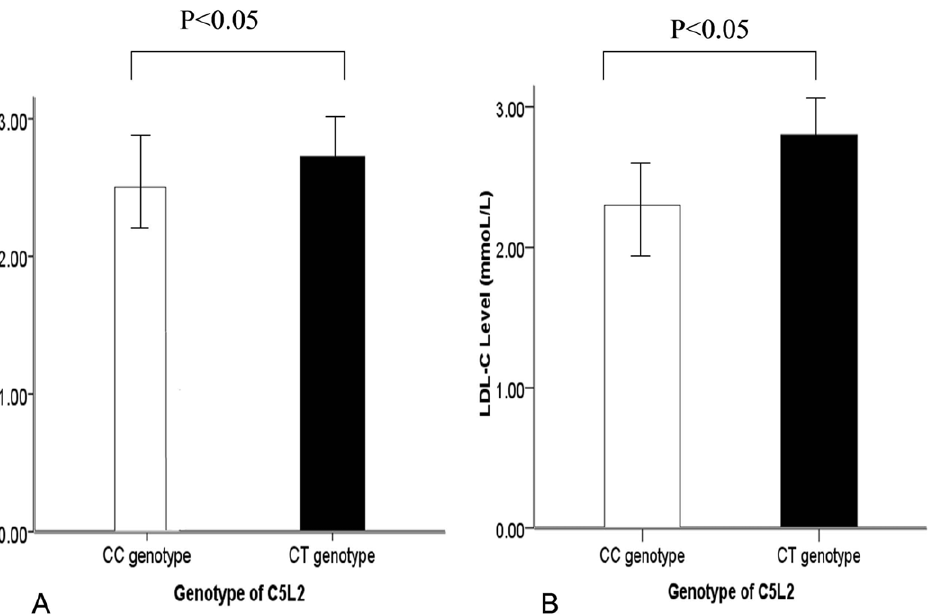
Figure 2. Plasma concentrations of LDL-C in patients with coronary artery disease (CAD). ( A ) In the Han population, LDL-C concentrations were significantly higher in subjects with the CT genotype than in subjects with the CC genotype. ( B ) In the Uygur population, LDL-C concentrations were significantly higher in subjects with the CT genotype than in subjects with the CC genotype.